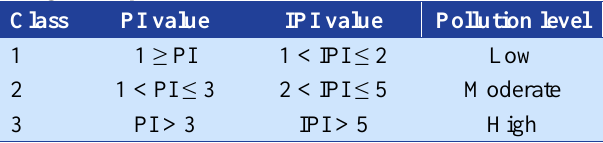
Table 2. Classification of pollution index (PI)